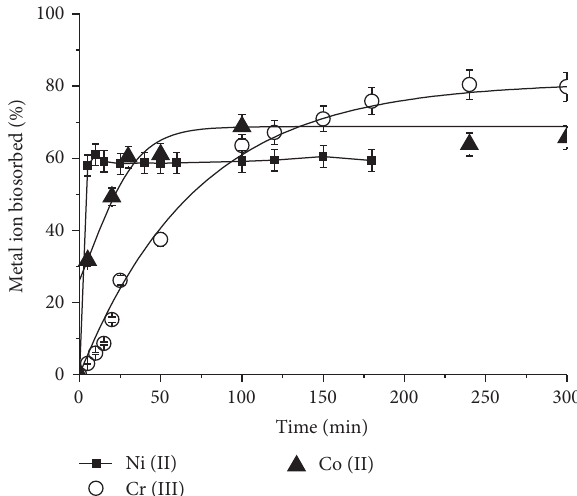
F 3: Contact time dependence pro�le for the biosorption of Ni(II), Cr(III), and Co(II) using Acalypha hispida